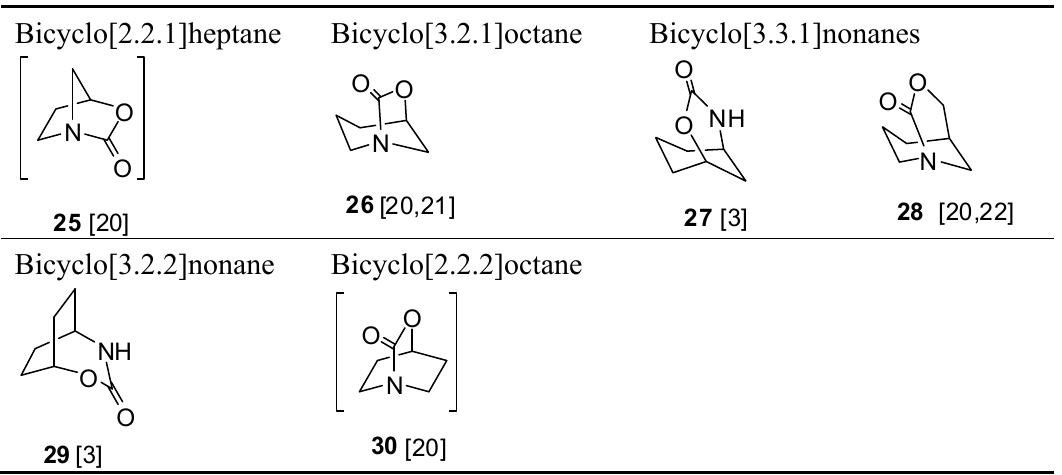
Table 3. Bicyclic urethane monomers 25–30